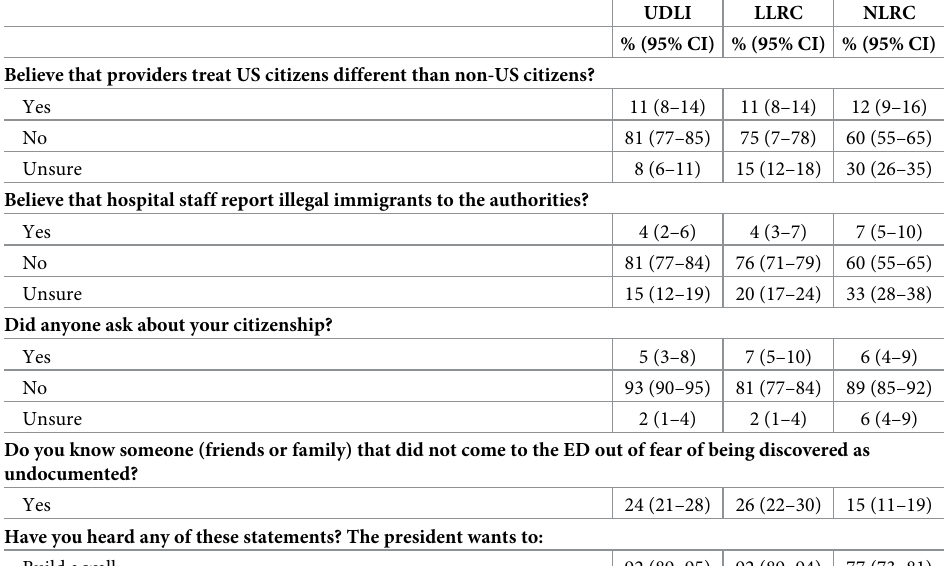
Table 2. Responses to key questions sorted according to study groups.